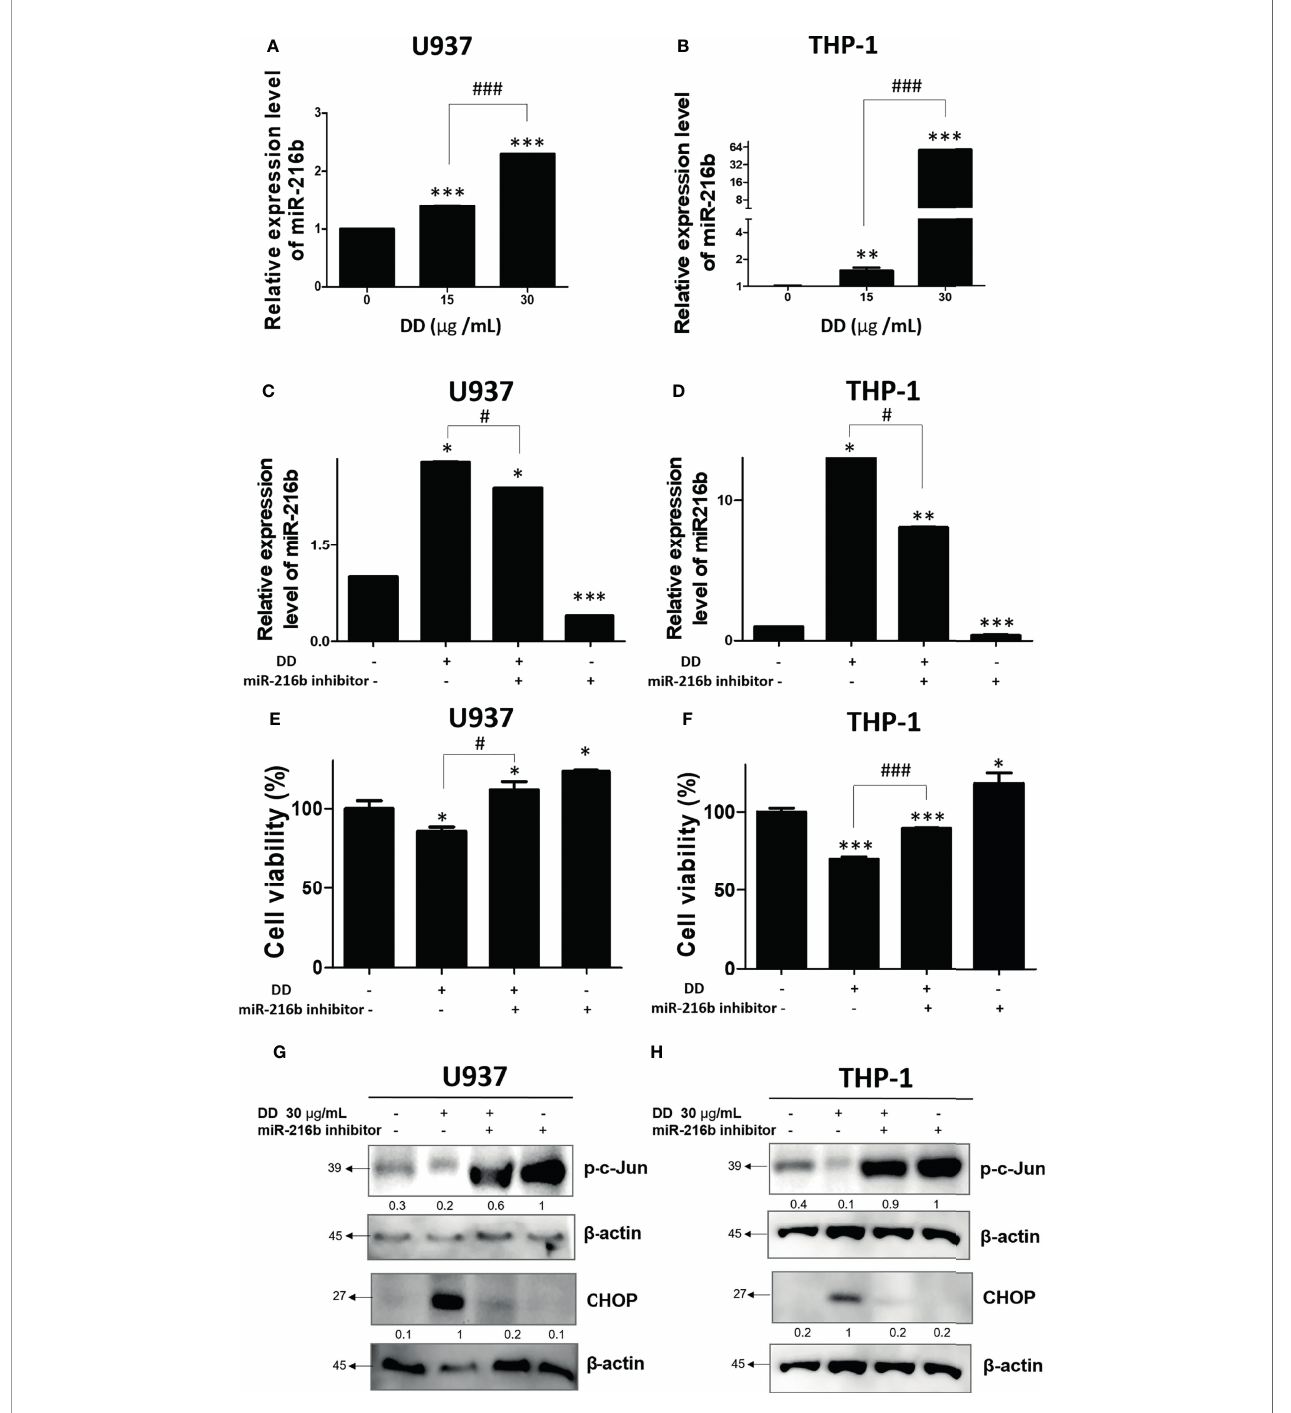
FIGURE 6 | Anticancer effect of Daemonorops draco Blume (DD) and reactivation of c-Jun and CCAAT/enhancer-binding protein-mediated apoptosis in acute myeloid leukemia cells. DD elevated the expression of miR-216b in (A) U937 and (B) THP-1 cells. AML cells were transfected with miR-216b inhibitor. (C – H) A total of 1 × 10 5 cells/ml were seeded into 6-well plates and allowed to reach approximately 50% density of transfection. The cells were transfected with miR-216b inhibitor for 48 h and exposed to the indicated doses of DD (i.e., 15 and 30 m g/ml) for 24 h. Following transfection for 48 h, miRNA was isolated and adopted to quantitative analysis of miRNA expression level or cell viability (E, F) , and Western blotting (G, H) was performed. Values represent the means of three experiments. Means ± standard deviation; * p < 0.05, ** p < 0.01, and *** p < 0.001 compared with untreated control group. # p < 0.05, and ### p < 0.001 between the two